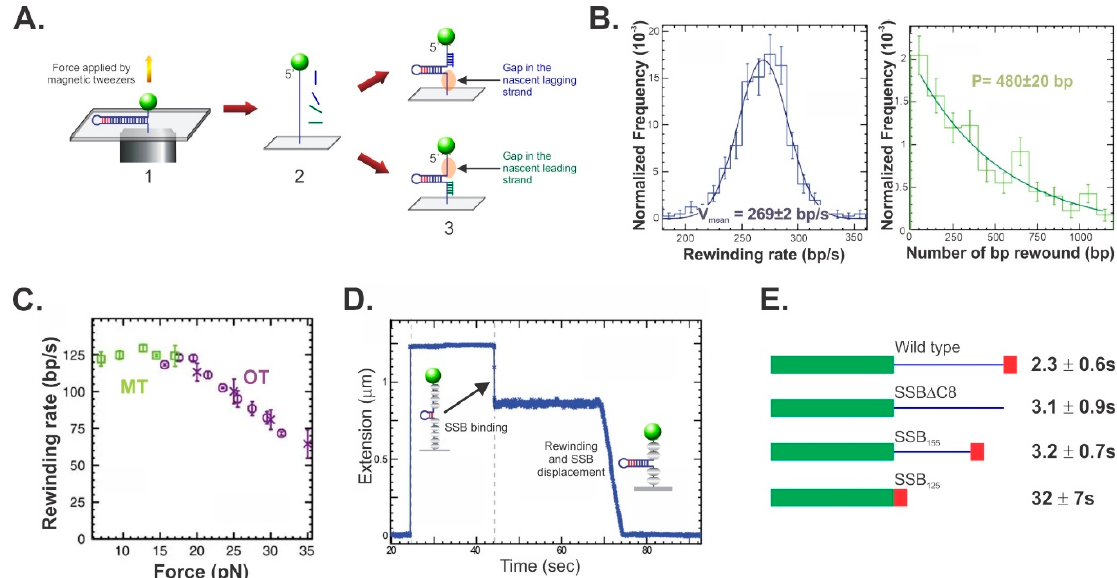
Figure 8. RecG catalyzes the key steps required for fork regression and displaces SSB in the process. ( A ) Construction of forks with gaps in either the leading or lagging strands. Here, the 1200 bp hairpin is fully stretched by the application of force from the magnetic tweezers. Then, oligonucleotides complementary to the 5 (cid:48) - or 3 (cid:48) -proximal regions are introduced in separate reactions and allowed to bind. Once the opposing force is decreased, a partial hairpin is extruded and as the oligonucleotide remains annealed to reveal a fork with a gap on the opposite side, either the lagging (top) or leading strand (bottom). ( B ), RecG rewinds forks with rates and processivity values consistent with a distance-limited fork regression reaction. The reactions rates and processivity of RecG-catalyzed fork rewinding at 37 ◦ C were obtained using the hairpin substrate shown in panel A. P, processivity. ( C ), RecG can work against large opposing forces during fork rewinding. MT, data from magnetic tweezer experiments. OT, data from assays using optical tweezers; ( D ), RecG readily displaces SSB during fork rewinding. Here, the hairpin is fully unwound by the application of force. When SSB is added, binding results in the wrapping of the polynucleotide around the tetramers. This causes a shortening of the DNA tether. ( E ), Functional linkers are required for SSB displacement by RecG during fork rewinding. Each SSB is colored green (N-terminal domain), blue (linker) and red, acidic tip. SSB 155 and SSB 125 are mutant proteins where the linker was either partially or completely removed, respectively. The values next to each protein, represent the lag time for rewinding to initiate following the addition of RecG. Data panels B-D are from [24] and panel E is from